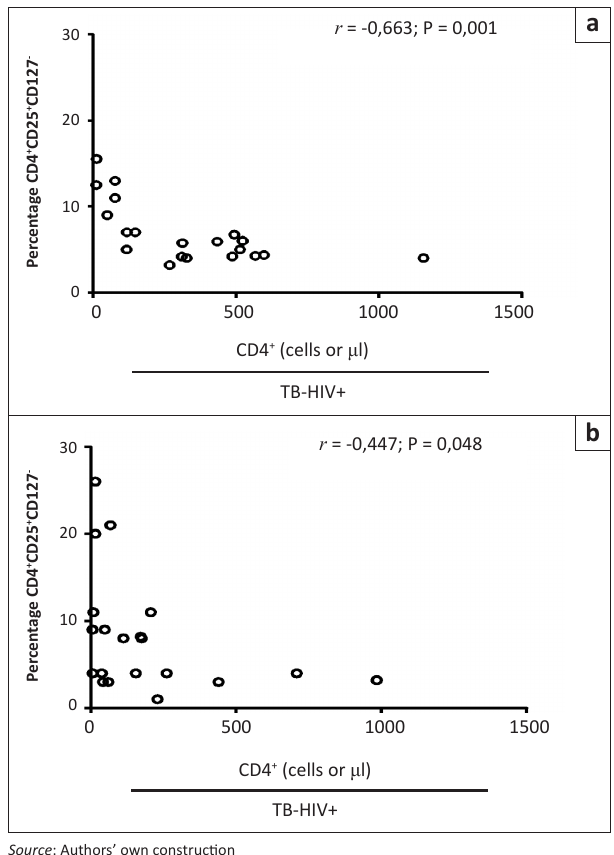
FIGURE 5: Regulatory T-cells. Representative box-and-whisker plot of percentage of CD4 + CD25 + CD127 – in the TB–HIV– ( n = 10), TB+HIV– ( n = 19), TB–HIV+ ( n = 20) and TB+HIV+ ( n = 20) groups.